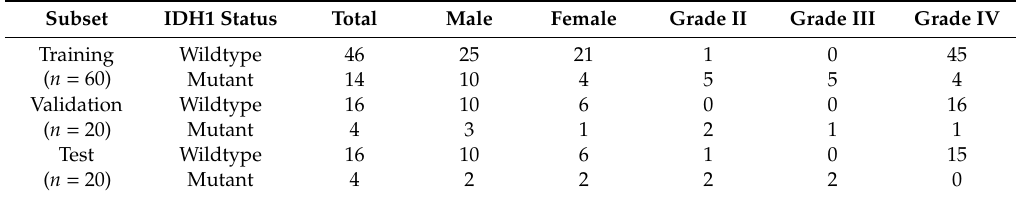
Table 2. IDH1 Status and Characteristics of Patients in Training / Validation / Test Sets.